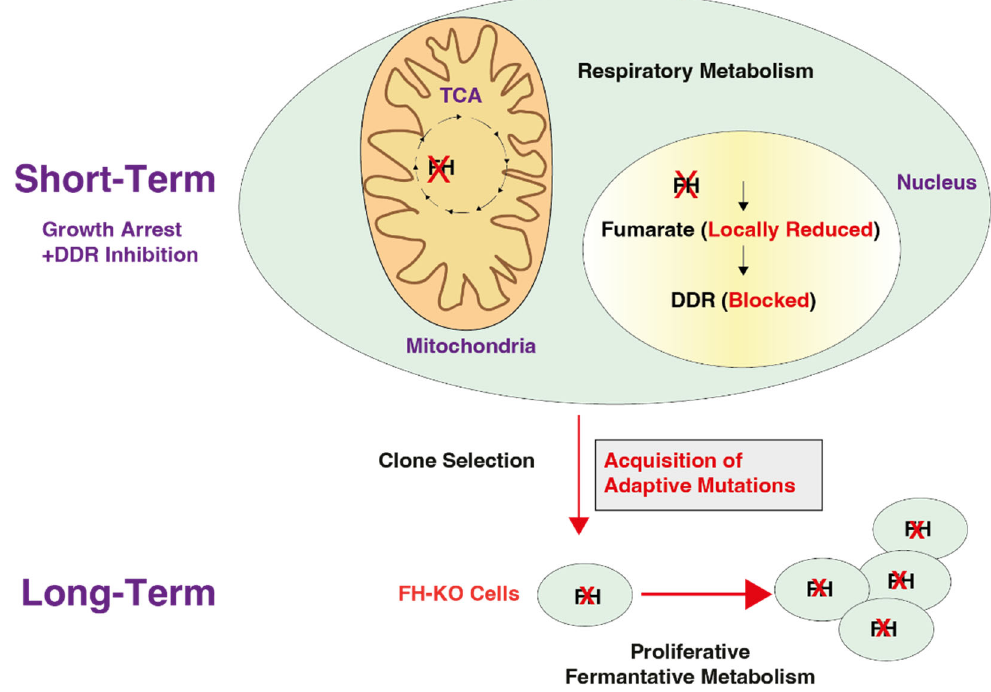
Figure 6. A scheme demonstrating the cellular behavior at the early stages of FH knockout and its long ‐ term result in selected clones. Immediately after FH KO, the cell proliferation rate decreases as the cells lose their ability to utilize the TCA cycle and to activate the DNA damage response (DDR) (Short ‐ Term). This blockage in the DDR induces mutagenesis that, in turn, results in the acquisition of adaptive mutations. By accumulating these mutations, the cell regains its proliferative abilities. The red cross is an indication of FH KO cells.